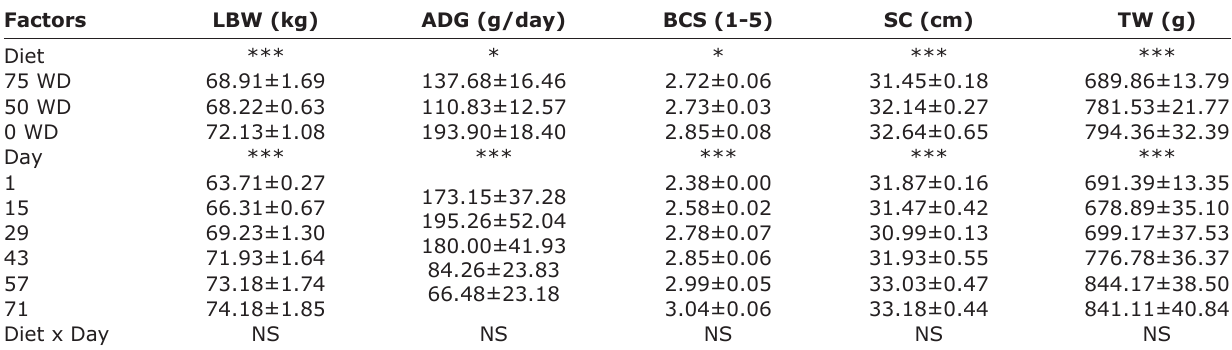
Table-2: Effects of diet and experimental day on LBW, BCS, and scrotal measurement of OD rams receiving 75%, 50%, or 0% of wasted date in the concentrate diet.